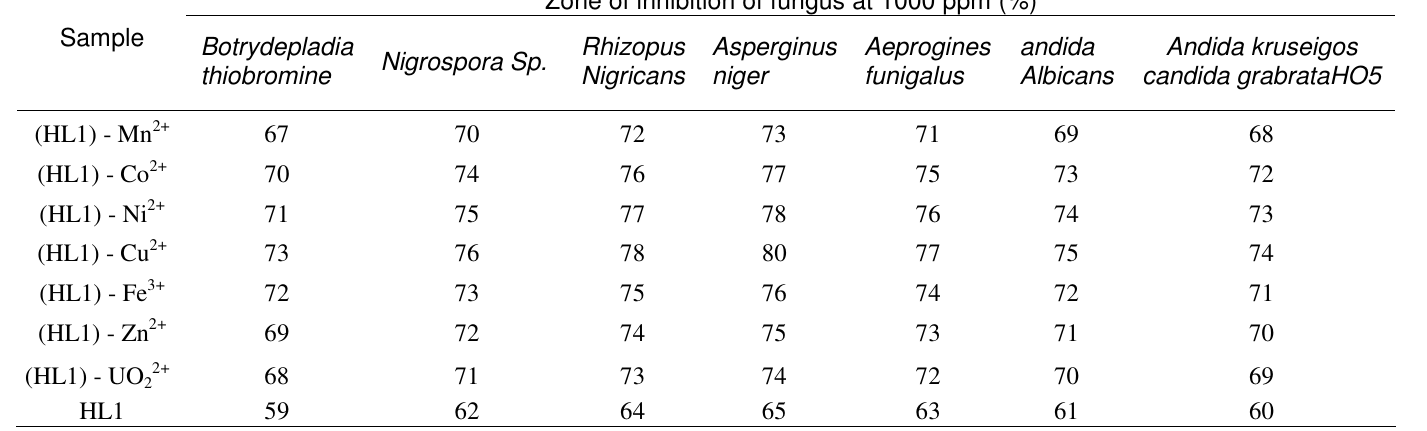
Table 3 . Antifungal Activity of Ligand HL Zone of inhibition of fungus at 1000 ppm